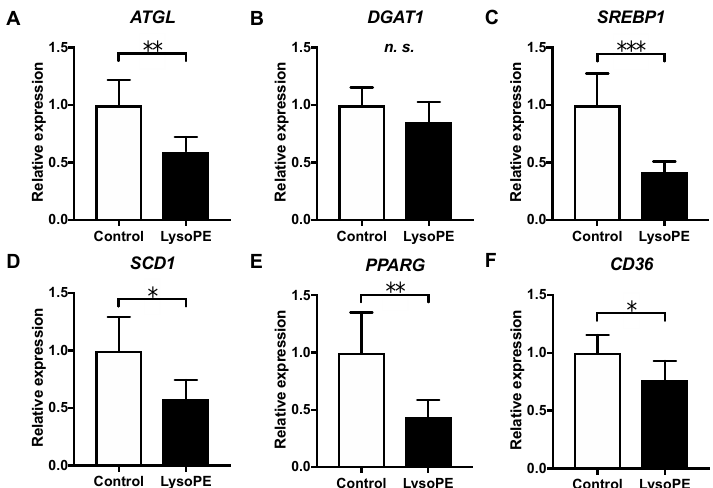
Figure 7. Expression of genes related to lipid droplet formation in lysoPE 18:2-supplemented and unsupplemented C3A cells. ( A ) ATGL ; ( B ) DGAT1 ; ( C ) SREBP1 ; ( D ) SCD1 ; ( E ) PPARG ( PPARγ ); ( F ) CD36 . The vertical axis shows the relative expression levels compared to the untreated control cells, which was set to 1.0. n = 6. Student’s t -test, * p < 0.05, ** p < 0.01, *** p < 0.001, n.s. not significant.